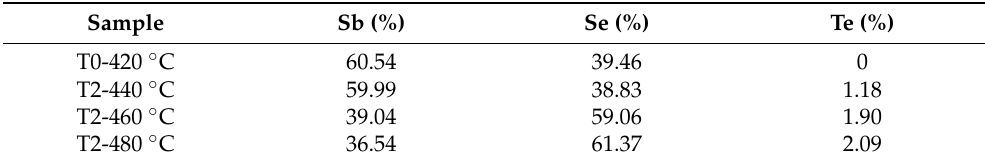
Table 1. Elemental composition of the Sb 2 Se 3 thin films deposited at the different doping condition (temperature).